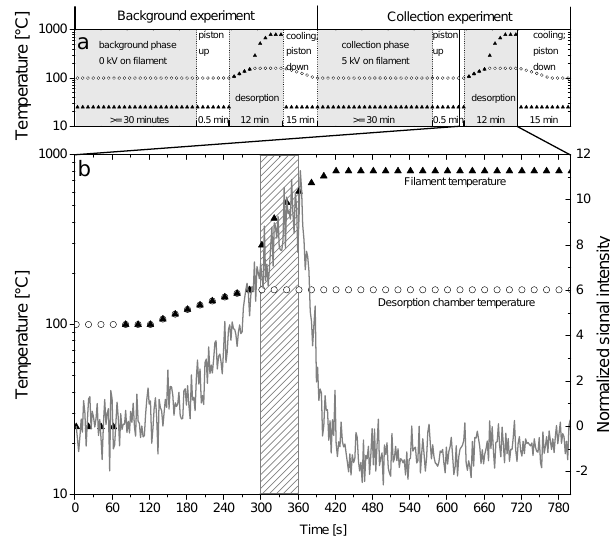
Fig. 6. (a) Sketch of the procedure for the background and collec- tion experiments, with temperature courses of the desorption cham- ber (white circles) and the NiCr filament (black triangles). (b) Time evolution of the averaged signal from major organic peaks ( m/z 43, 53, 65, 67, 77 and 91) during the desorption of oxidized alpha- pinene particles. The PEEK piston was in desorption position at second 60. Temperatures of the desorption chamber and the filament are also shown. The hatched area denotes the one-minute averaging period used for the mass spectrum shown in Fig.